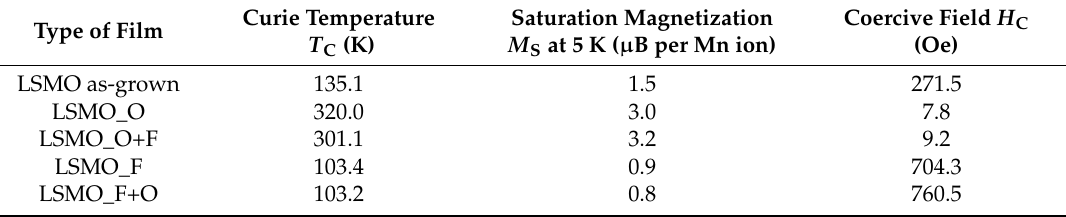
Table 3. Values of saturation magnetization ( M s), Curie temperature ( T c) and coercive field ( H c) as obtained from the magnetization measurements shown in Figure 4. Experimental errors are within 10%